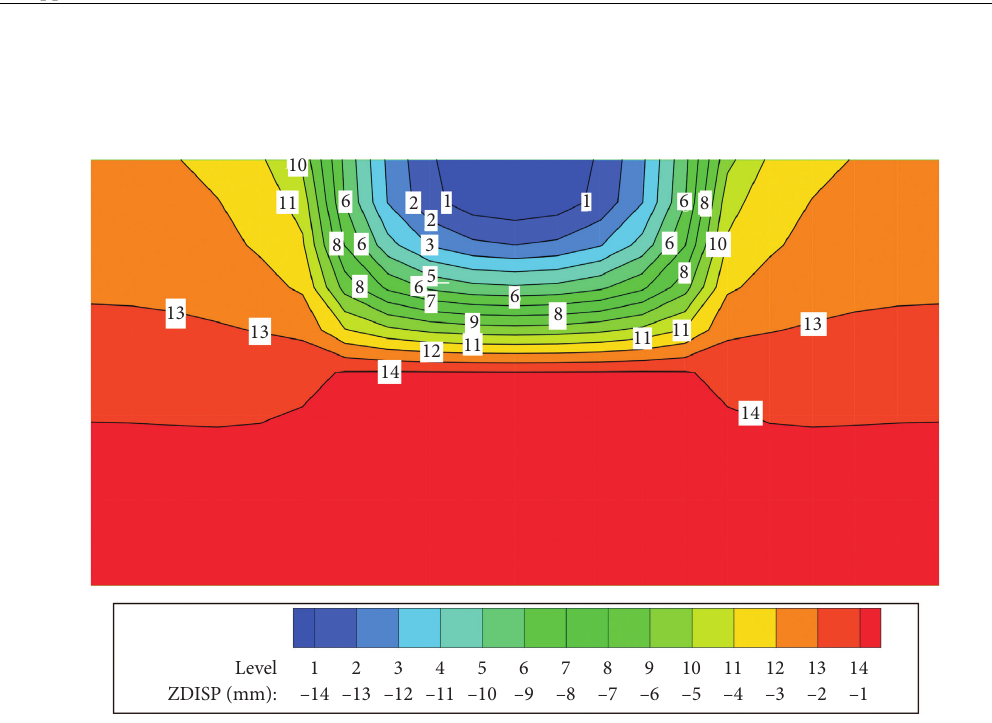
Figure 5: Calculation result of the modulus reduction